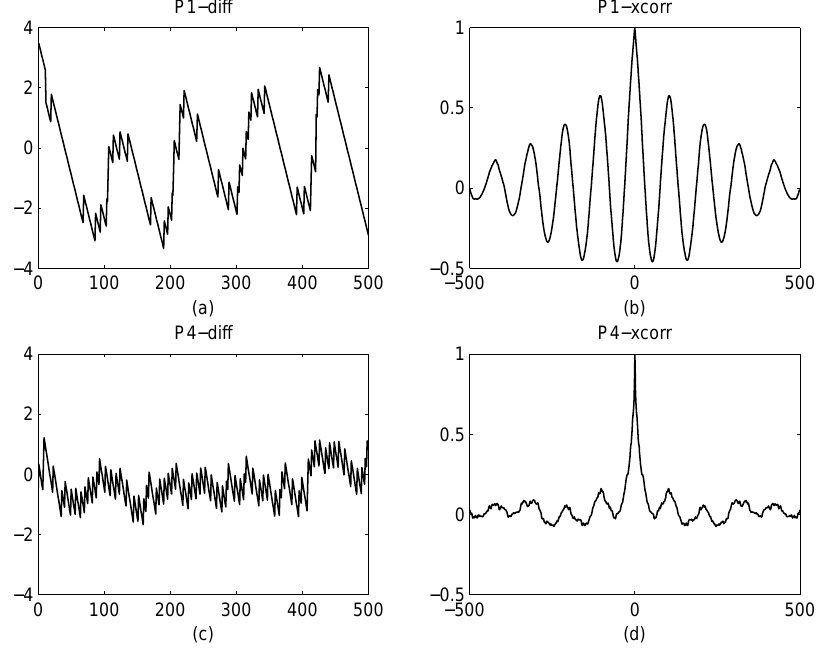
Figure 6. In this figure, ( a ) and ( c ) are resulting vector f n of P1 and P4, respectively. ( b ) and ( d ) are the autocorrelation of P1 and P4. The autocorrelation of P1 has a strong oscillation, similar to a periodic signal. However, the autocorrelation of P4 has a random oscillation, similar to a white noise signal. The ratio of maximum and sidelobe maximum,